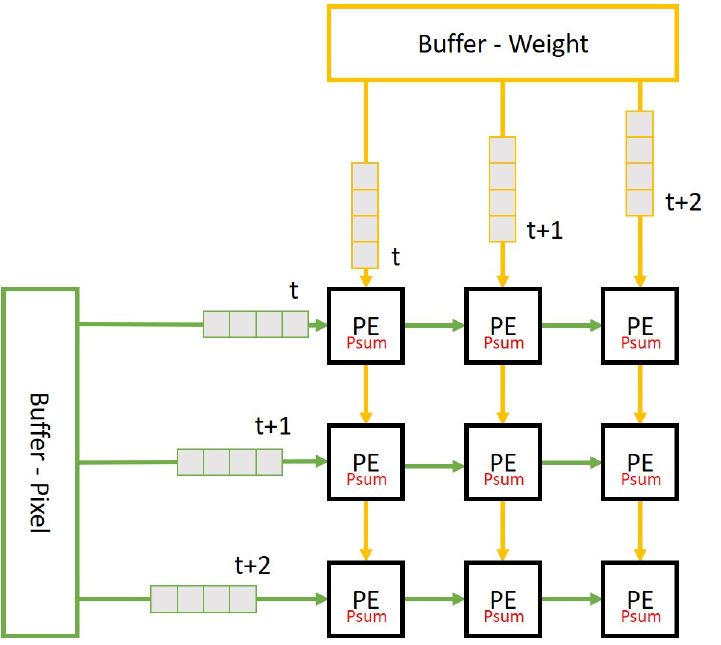
Figure 8. The output stationary dataflow.